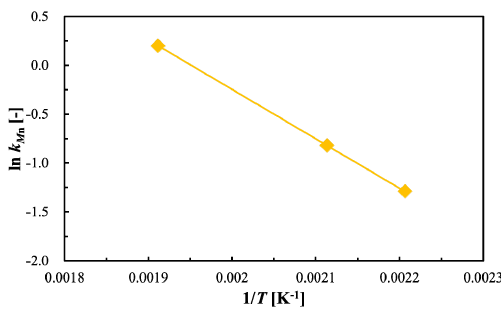
Figure 3. Arrhenius plot of reduction in polylactic acid (PLA) molecular weight in sub-critical water.